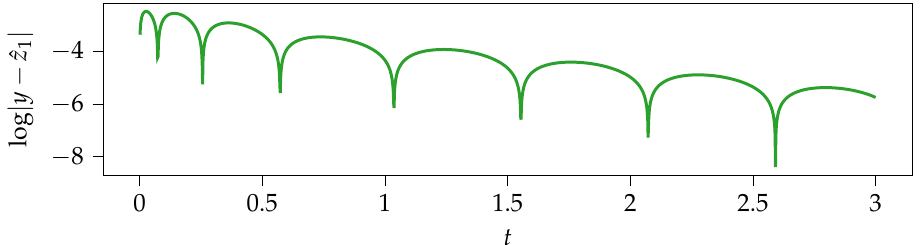
Figure 3. Observer error for the Duffing oscillator (logarithmic scale).